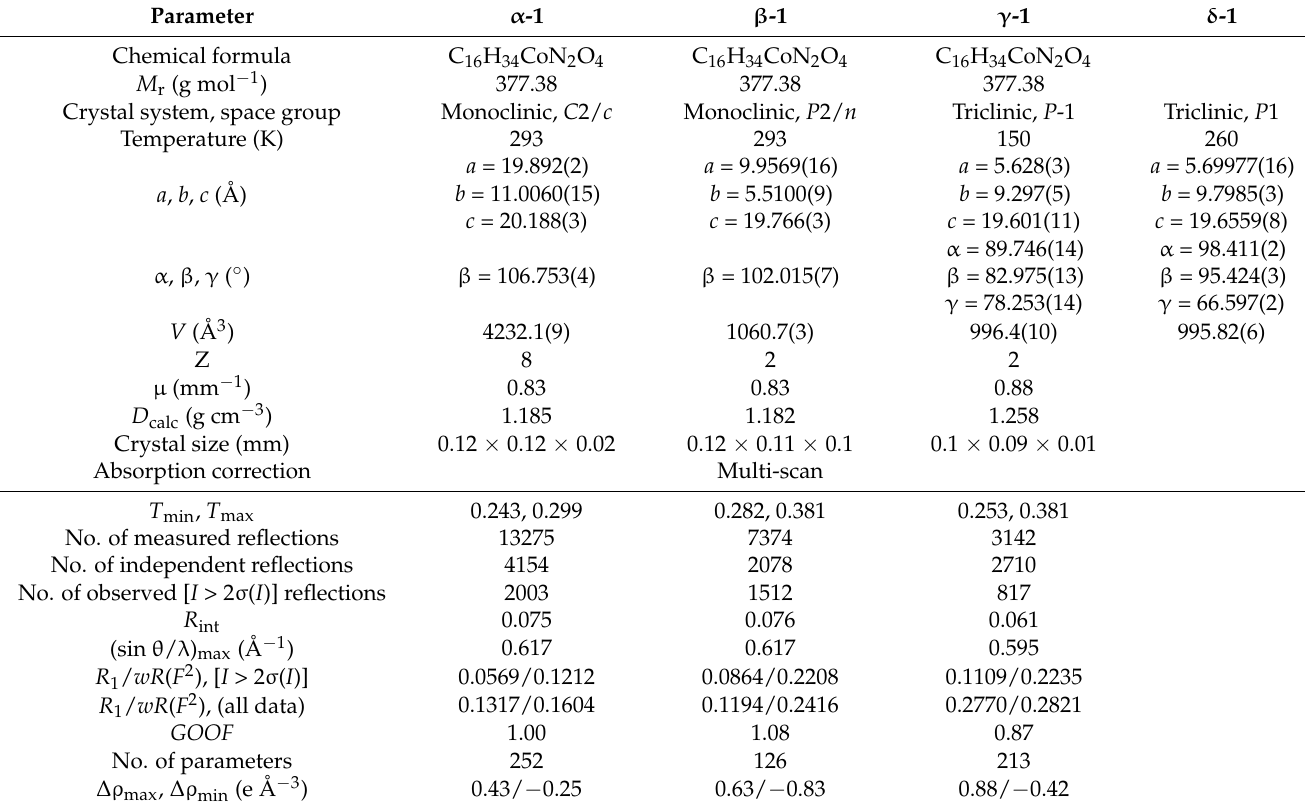
Table 1. The main crystallography data and refinement details for structures α - 1 , β - 1 , γ - 1 and δ - 1